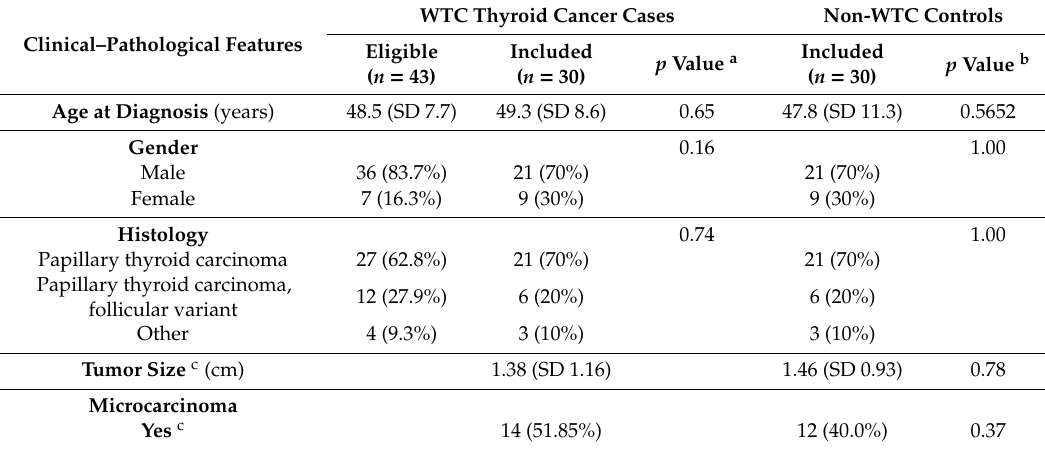
Table 1. Characteristics of the study